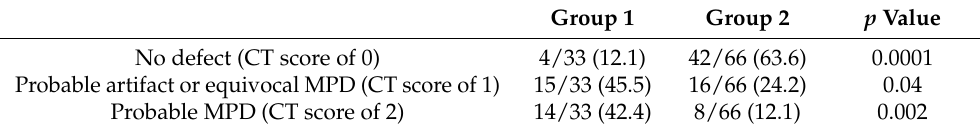
Table 2. Differences in the CT scores for myocardial perfusion defect between groups 1 and 2.